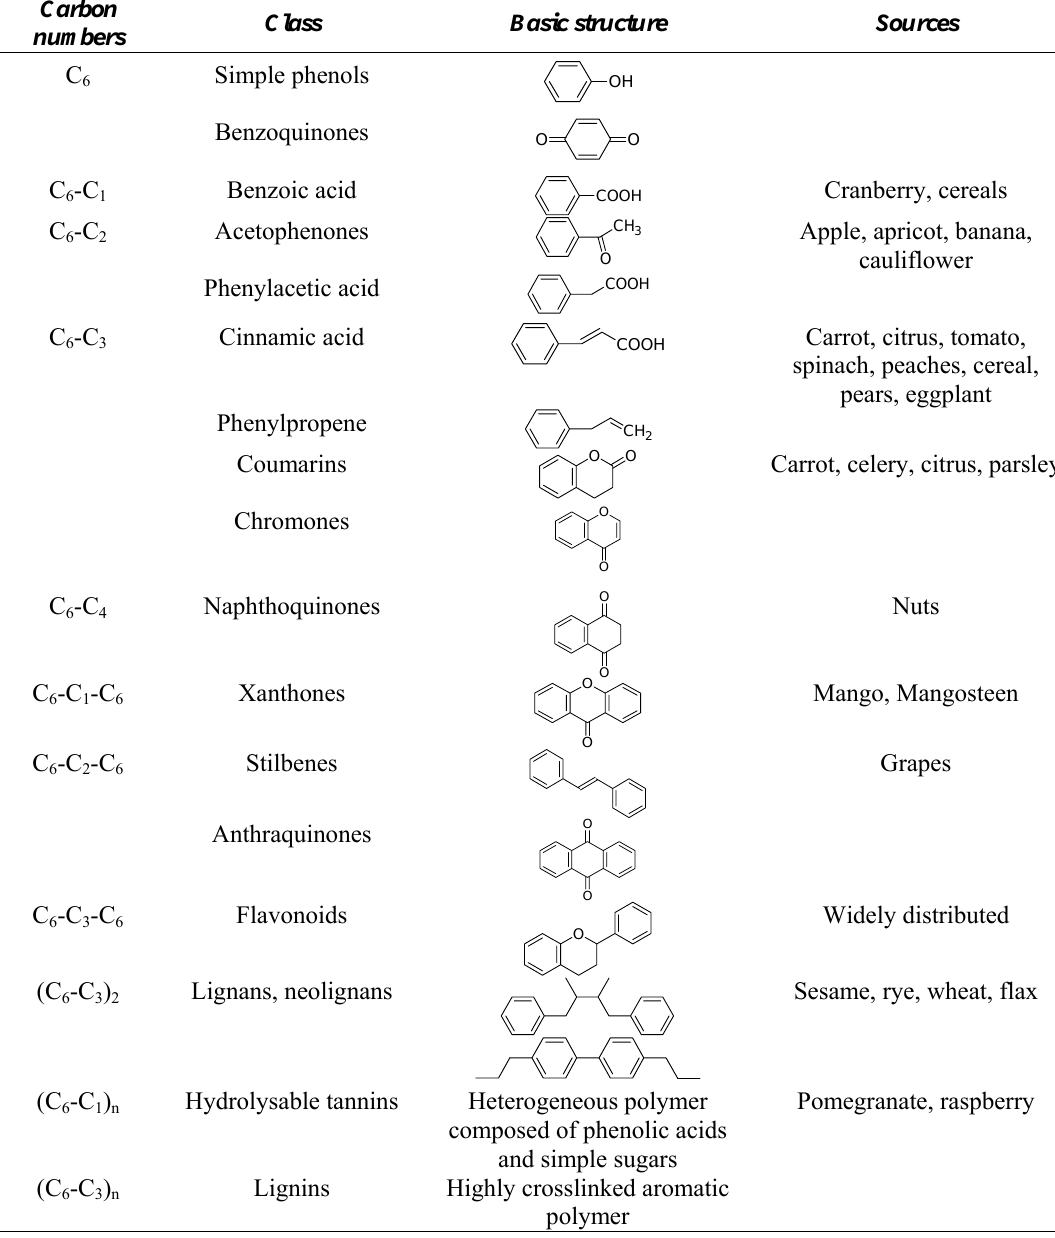
Table 1. Classification of families of phenolic